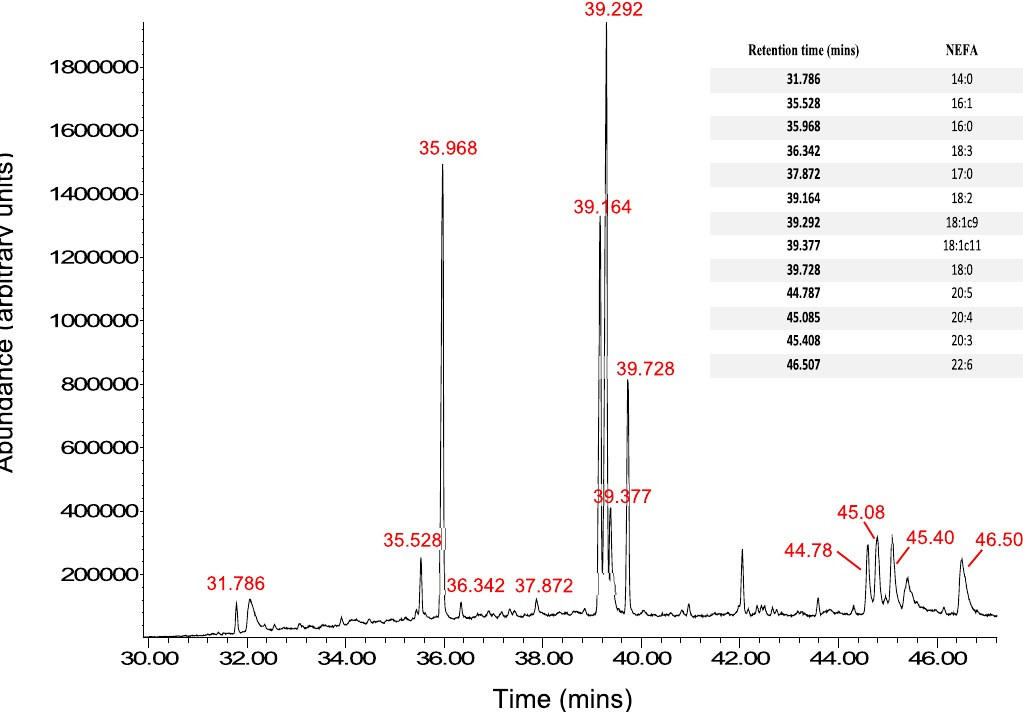
Figure 2. Example GC:MS chromatogram showing points of separation of individual FAMEs. The retention times of peaks corresponding to individual NEFA species are shown in the